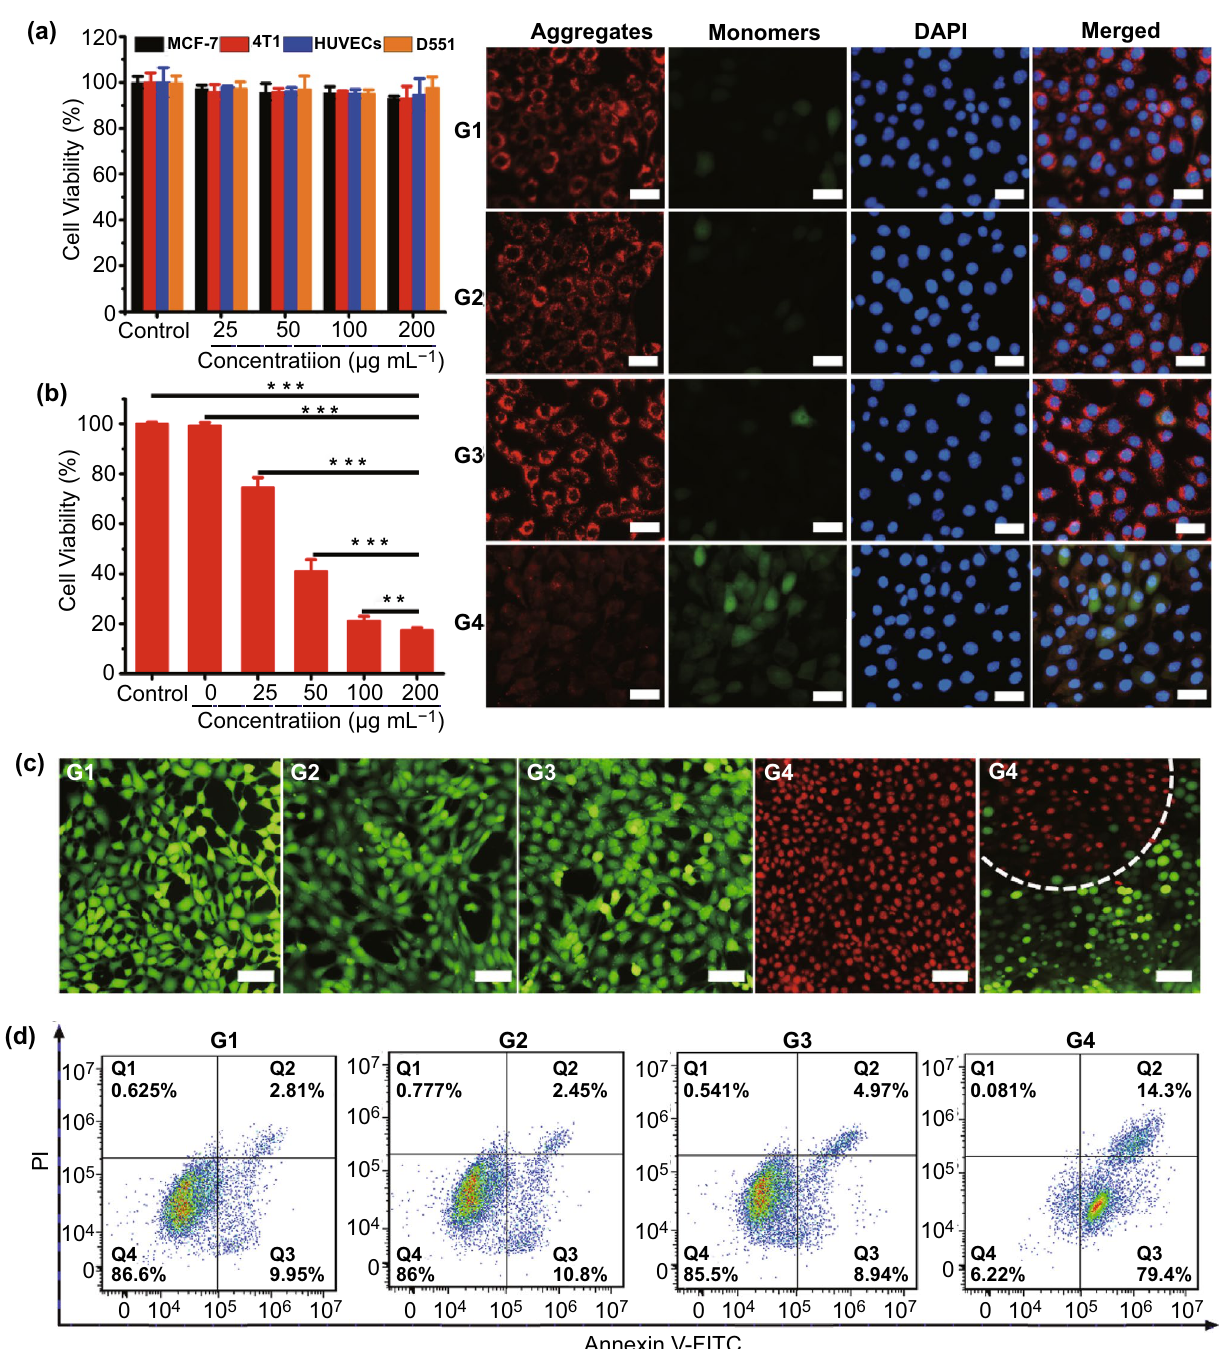
Fig. 3 a Cytotoxicity of SnNSs@PEG with different concentrations against various cell lines after 24‑h incubation. b Survival rate of 4T1 cells after treated with SnNSs@PEG and NIR laser (808 nm, 1 W cm −2 ) irradiation for 5 min. c Live/dead fluorescence staining images of cells (red: dead, green: live) after different treatments: G1: Control, G2: NIR, G3: SnNSs@PEG, G4: SnNSs@PEG + NIR (scale bar = 25 µm). d FCM apoptosis analysis of 4T1 cells after different treatments: G1: Control, G2: NIR, G3: SnNSs@PEG, G4: SnNSs@PEG + NIR. e Changes of MMP in 4T1 cells after different treatments: G1: Control, G2: NIR, G3: SnNSs@PEG, G4: SnNSs@PEG + NIR (JC ‐ 1 monomers: green, JC ‐ 1 aggregates: red) (scale bar = 50